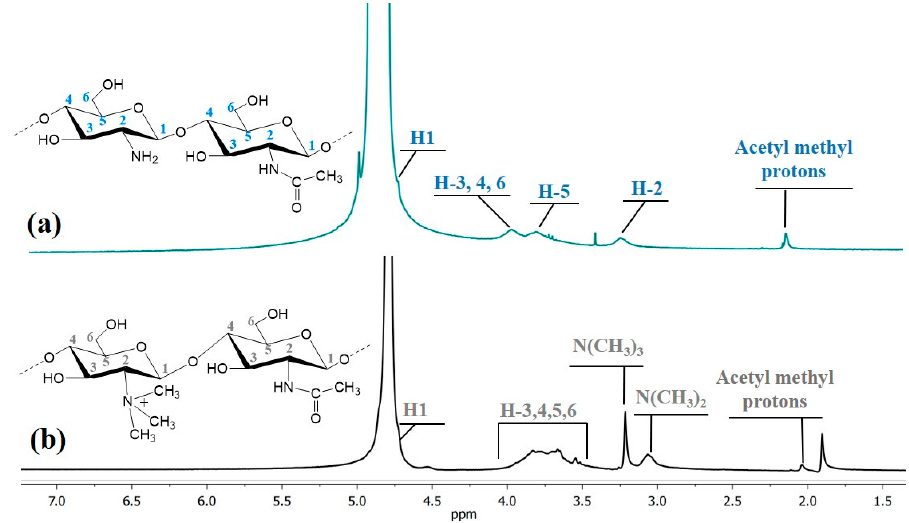
Figure 1. 1 H-NMR spectra of ( a ) pristine chitosan (in DCl); ( b ) TMC (in D 2 O).